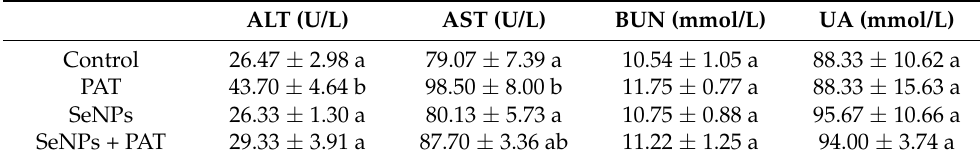
Table 1. Serum biochemical parameters of the control and trial groups